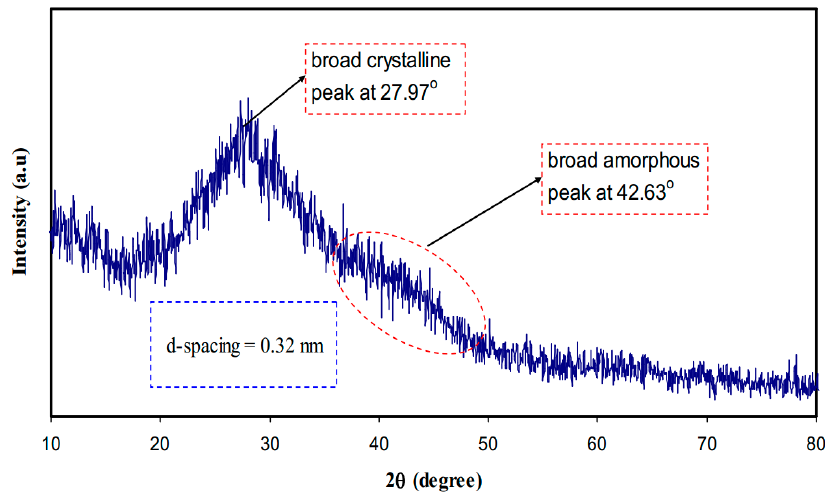
Figure 20. CN-dots XRD spectrum at room temperature [191].